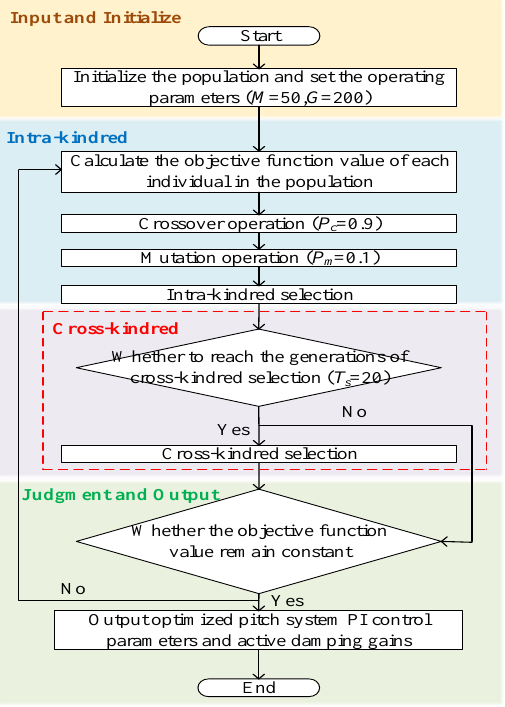
Figure 5. The flow of the KPGA.